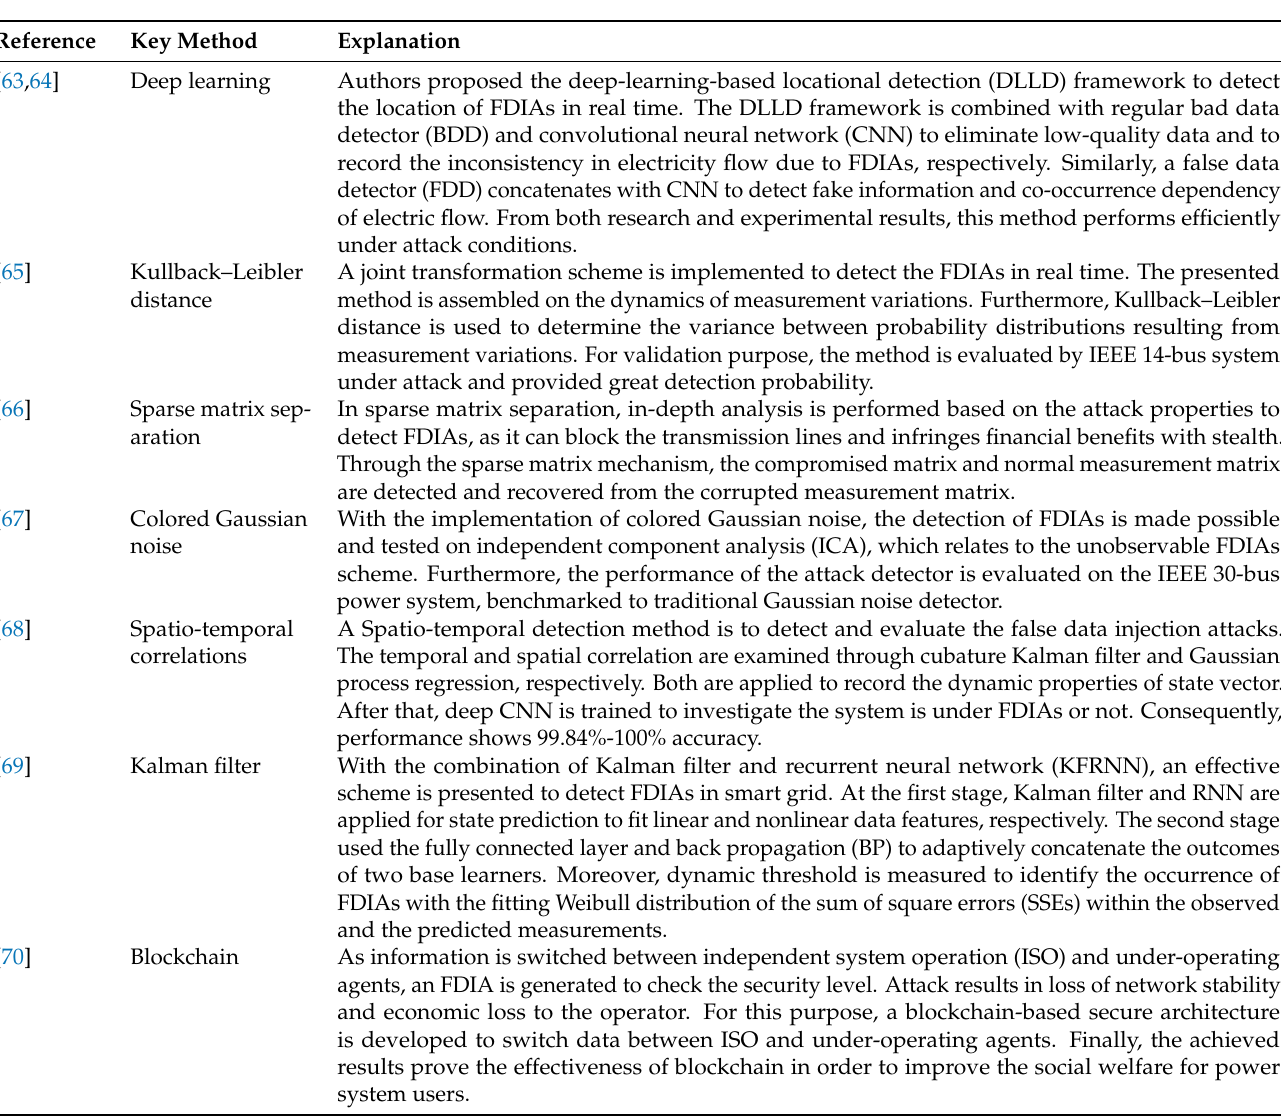
Table 3. Methods and countermeasures to defend against